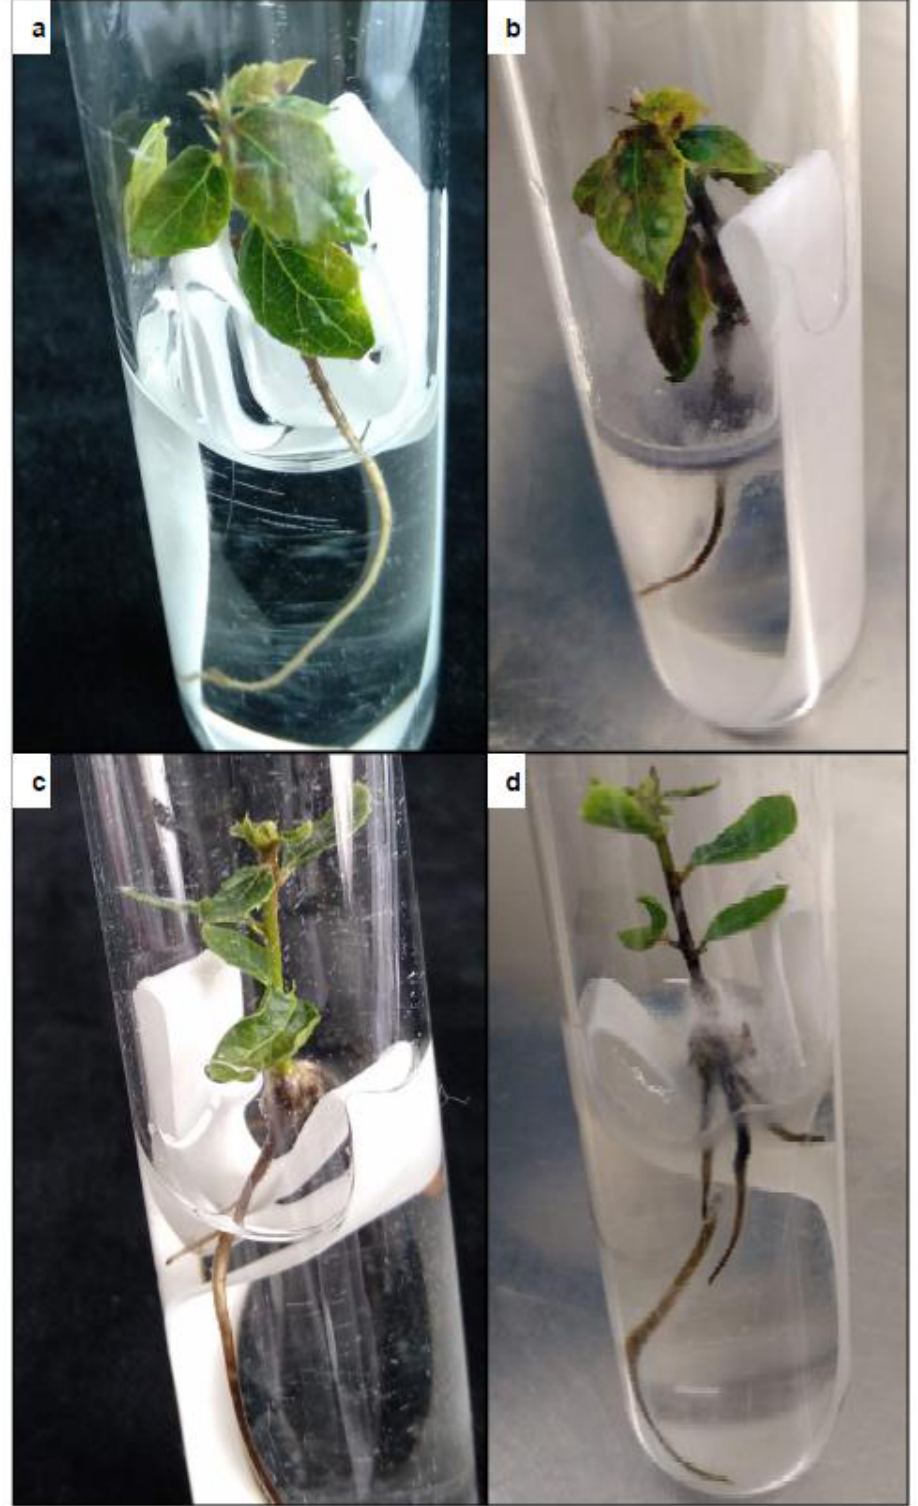
Figure 6. Morphological appearance and progress of infection in non-transgenic plantlets ( a , b ) and transgenic plantlets ( c , d ) of genotype ALM80 immediately after inoculation ( a , c ) and 15 days later ( b , d ). Diameter of the tube: 20 mm.